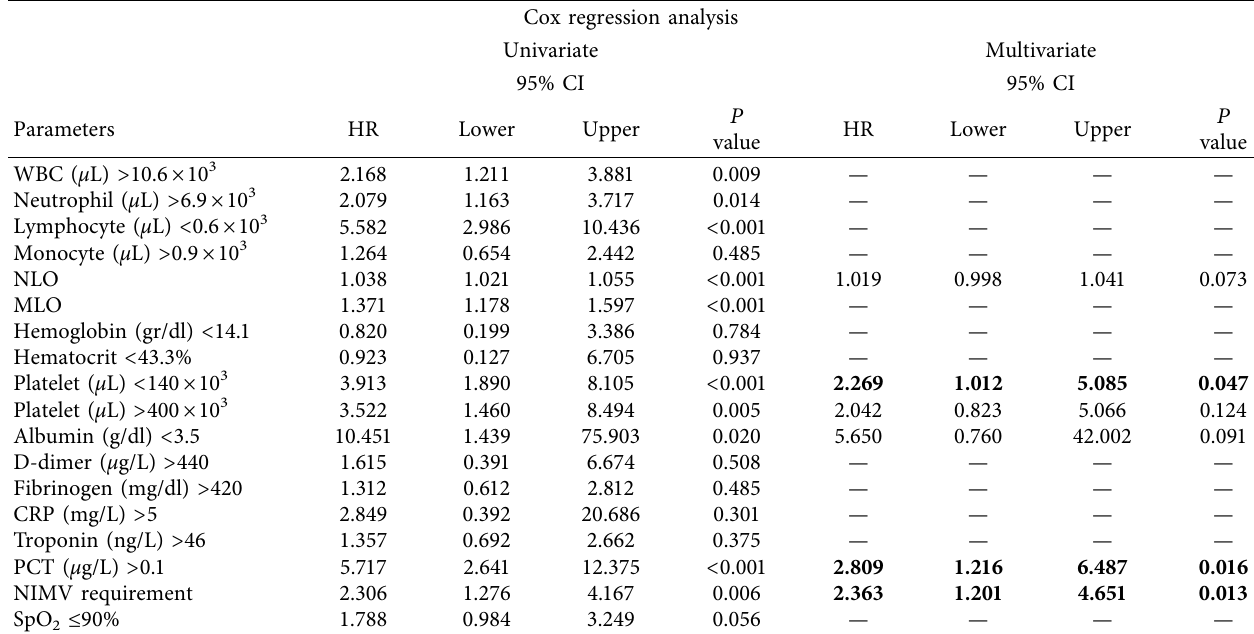
Table 4: Univariate and multivariate Cox regression analysis and parameters at the time of discharge predicting mortality. Cox regression analysis